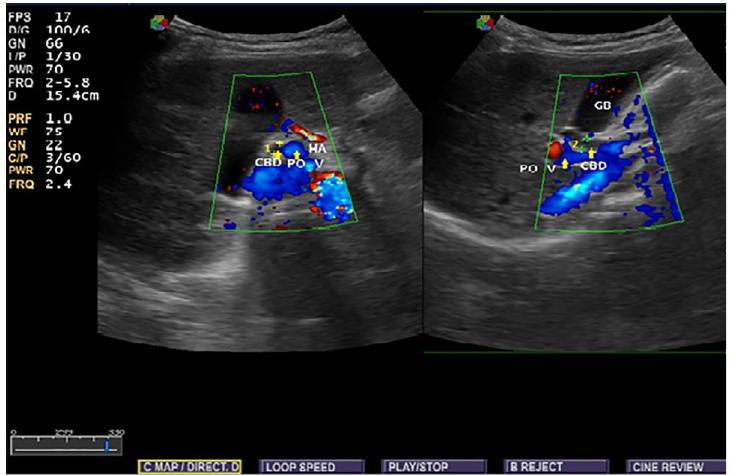
Fig 2. Transverse and longitudinal view showing the measurement of the diameter of the common bile duct at the portal hepatics (POV-portal vein, CBD common bile duct, HA hepatic